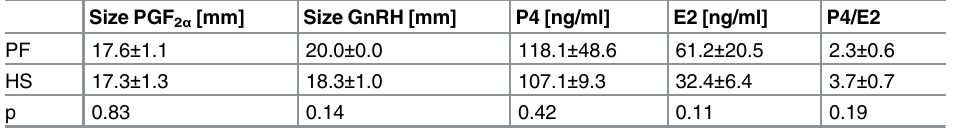
Table 2. Size of dominant follicles as determined by ultrasonography at the times of treatment with PGF 2 α and GnRH, and intra-follicular steroid contents.